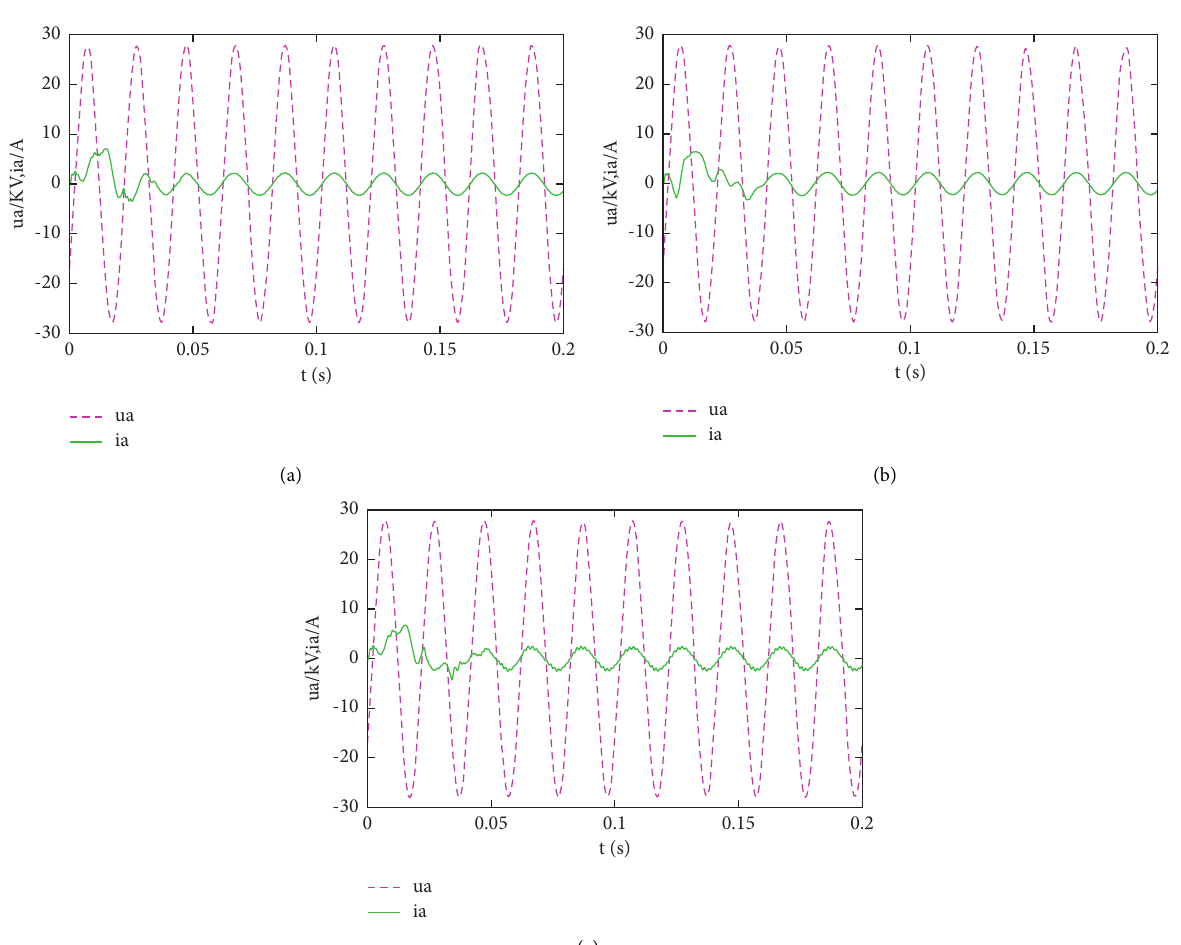
u i a and a response curves of the improved ADRC. (b)